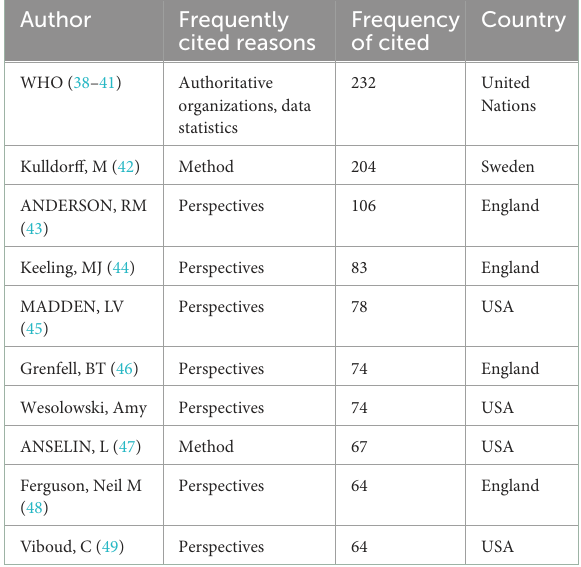
TABLE 6 Top 10 high-impact